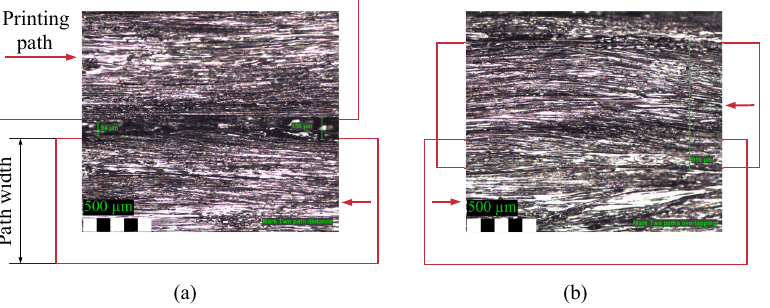
Figure 7. Micrographs of one selected area of one bending test specimen (top view). In ( a ) there is a visible gap between two printed filaments, in ( b ) the filaments overlap. The density of voids strongly depends on the way filaments are